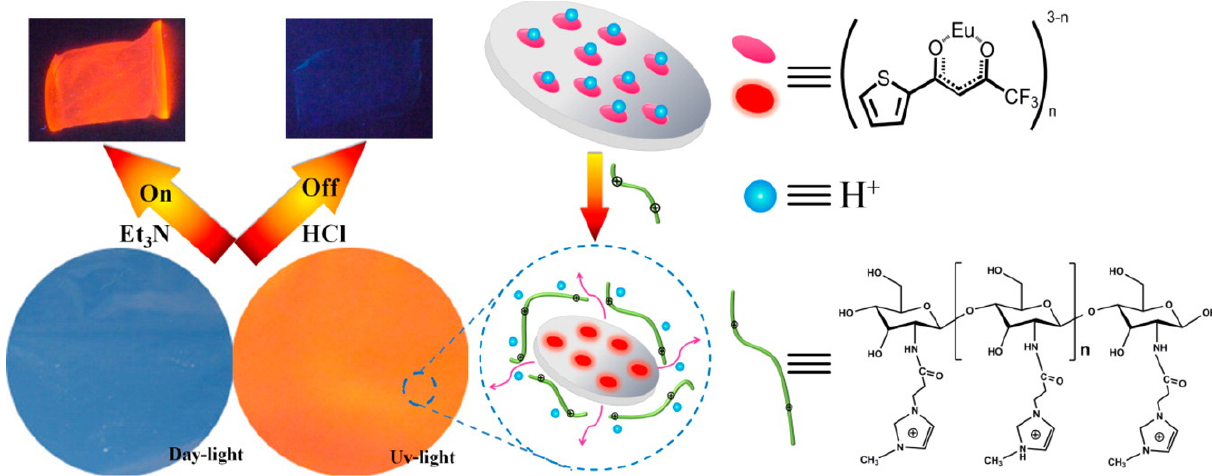
Figure 2. Schematic of the vapor-sensitive luminescent sensors based on chitosan, nanoclay, europium (III) complexes and carboxyl-functionalized ionic liquids. Reproduced with permission from [10].